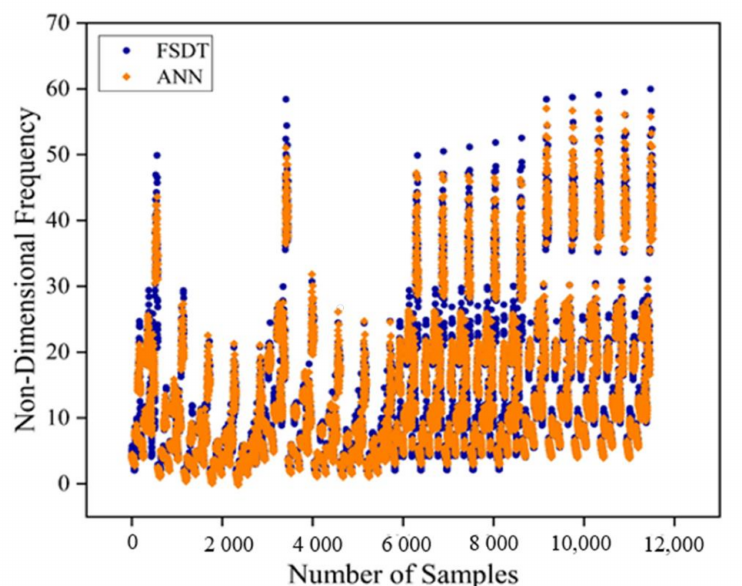
Figure 7. Scatter plot to compare the target results and the ANN predicted fundamental natural frequency values.